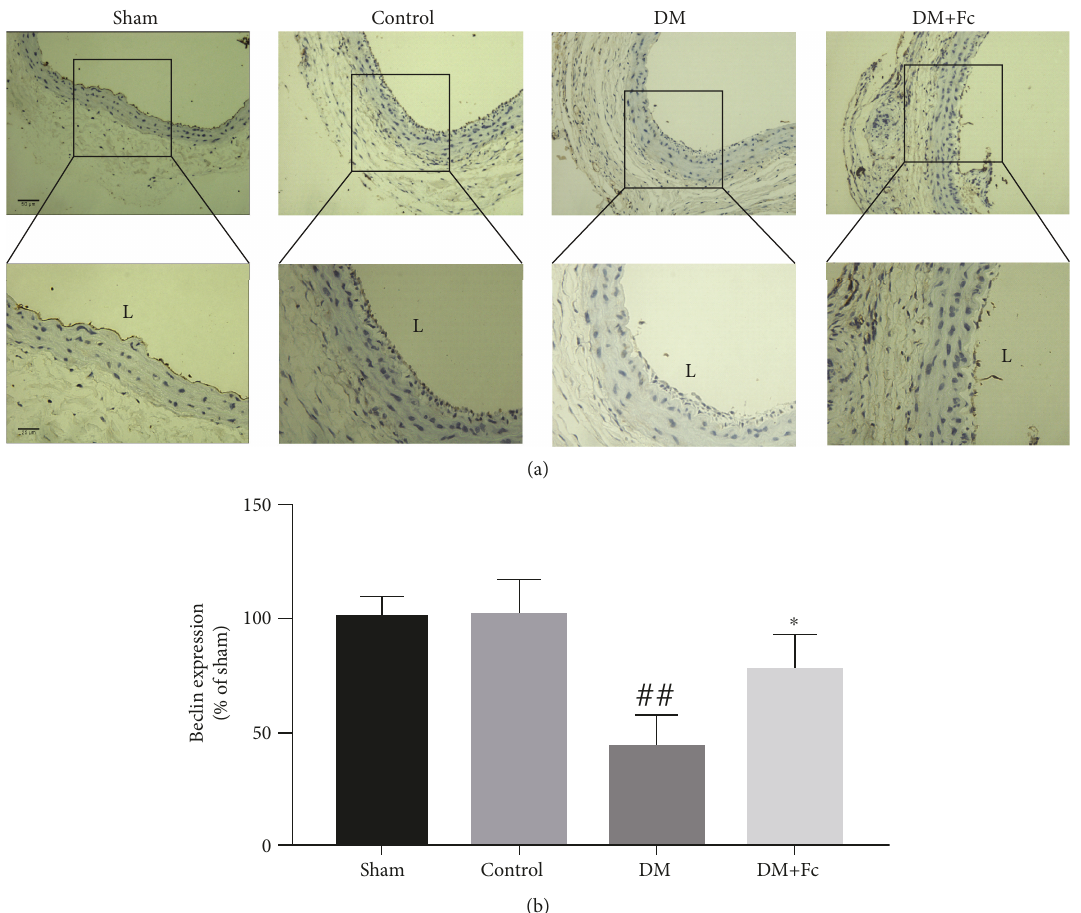
Figure 4: E ff ects of notoginsenoside Fc (Fc) on Beclin 1 protein of the intima following carotid artery injury. (a) Representative images by immunohistochemistry showing Beclin 1 protein in brown. Beclin 1 protein was found predominantly in the intima. L represents lumen. Images are at 200x and 400x magni fi cation. Scale bars = 50 μ m and 25 μ m. (b) The number of Beclin 1-positive cells was counted and analyzed statistically in fi ve random high-power fi elds. Data are shown as the mean ± standard deviation. ## P < 0 01 vs. the control group; ∗ P < 0 05 vs. the diabetes mellitus (DM) group. n = 6